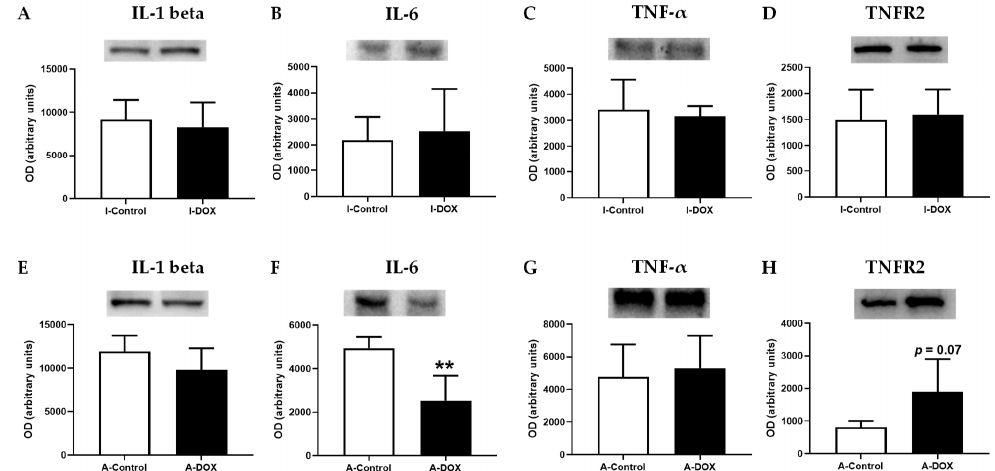
Figure 10. ( A , E ) Interleukin-1 beta (IL-1 beta) (35 kDa), ( B , F ) interleukin-6 (IL-6) (24 kDa), ( C , G ) tumor necrosis factor- α